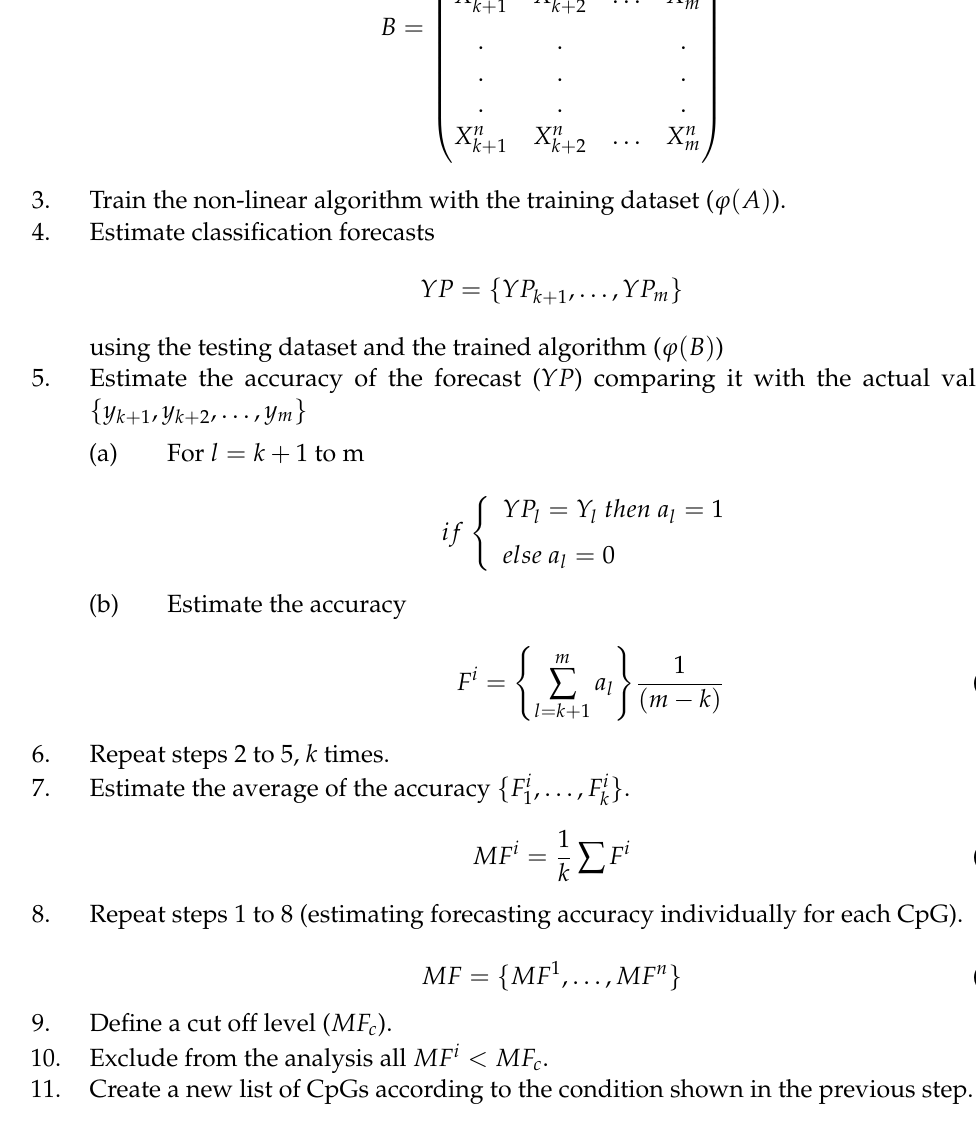
Note: the dimensionality has been reduced from n to nn